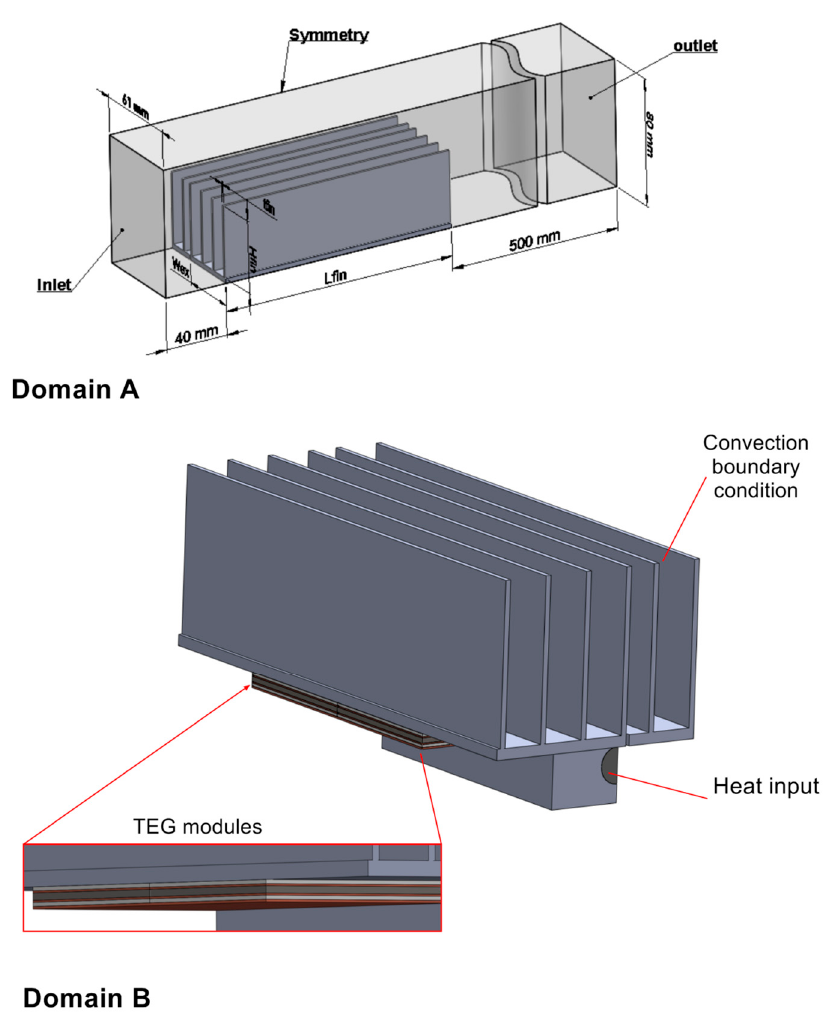
Figure 3. Computational domains A and B.